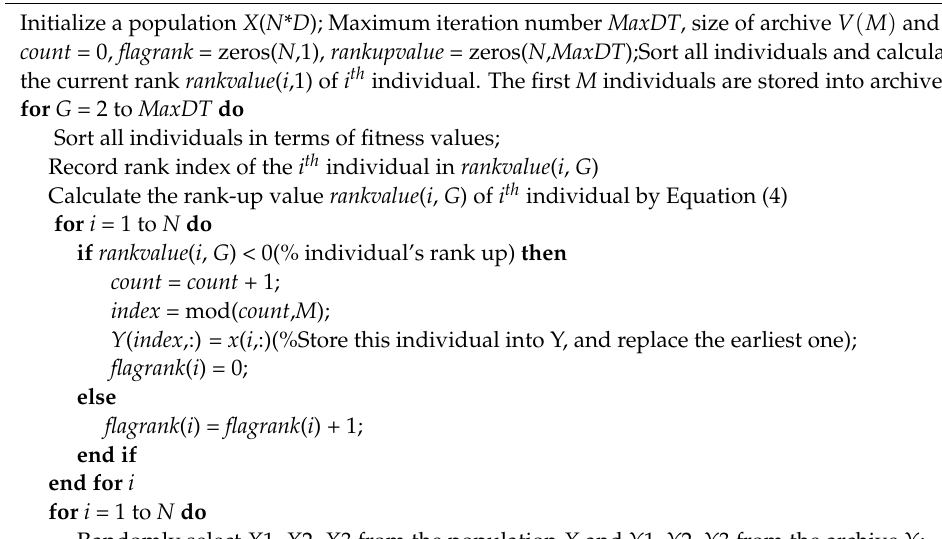
Algorithm 2 The pseudo code of